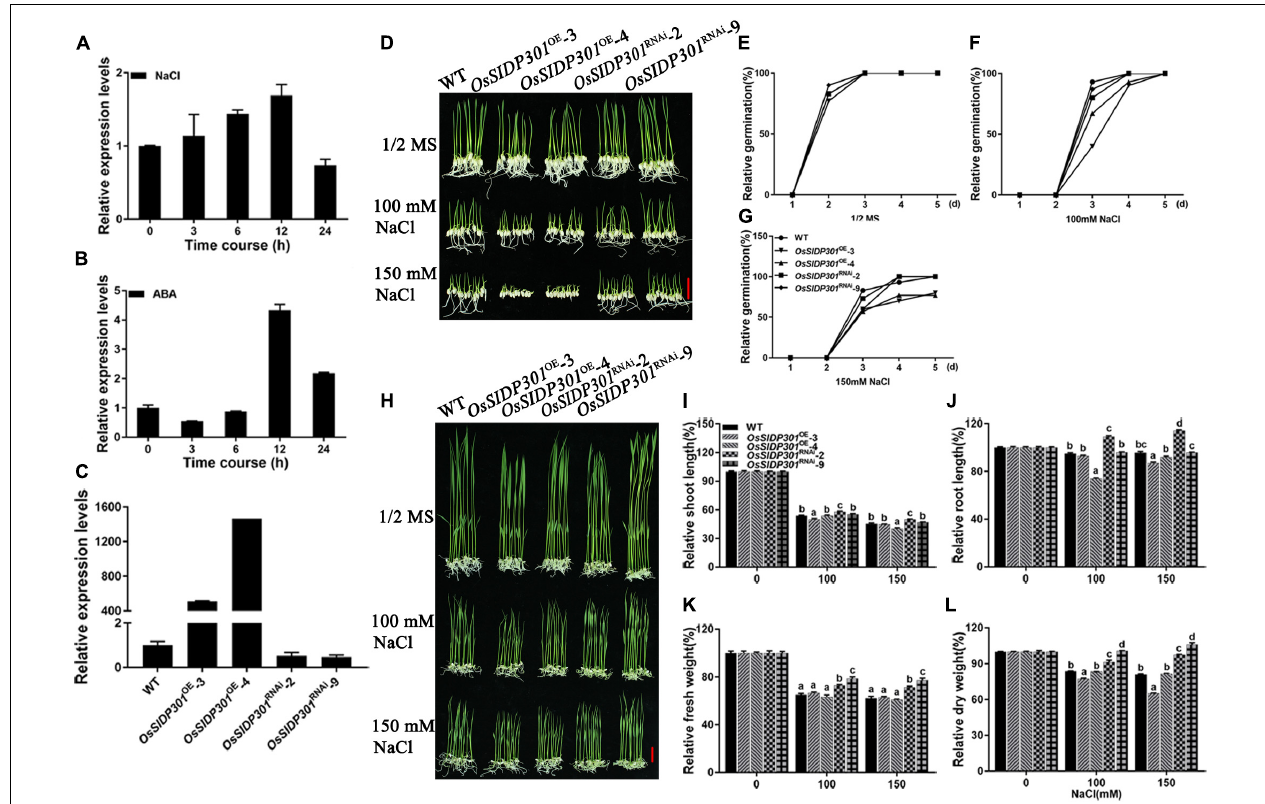
FIGURE 2 | Phenotype of OsSIDP301 transgenic plants with NaCl treatment. Transcript levels of OsSIDP301 were induced by 100 mM NaCl (A) and 100 µ M ABA (B) in 3-week-old seedlings. (C) Relative expression levels of OsSIDP301 between WT, OsSIDP301 OE , and OsSIDP301 RNAi plants. (D) Phenotype of OsSIDP301 transgenic plants with NaCl treatment at germination stage, bar = 2 cm. Comparisons of germination rate between WT, OsSIDP301 OE , and OsSIDP301 RNAi plants under normal condition (E) and with NaCl treatment for 7 days (F,G) . (H) Phenotype of OsSIDP301 transgenic plants with NaCl treatment at the seedling stage, bar = 2 cm. Comparisons of shoot length (I) , root length (J) , fresh weight (K) , and dry weight (L) between WT, OsSIDP301 OE , and OsSIDP301 RNAi plants with or without NaCl treatment for 7 days. Data are shown as mean ± SD ( n = 8), different letters suggest significant difference at P <